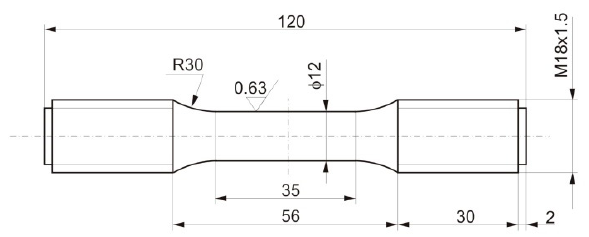
the ϕ 360 mm × 75 mm pipe.